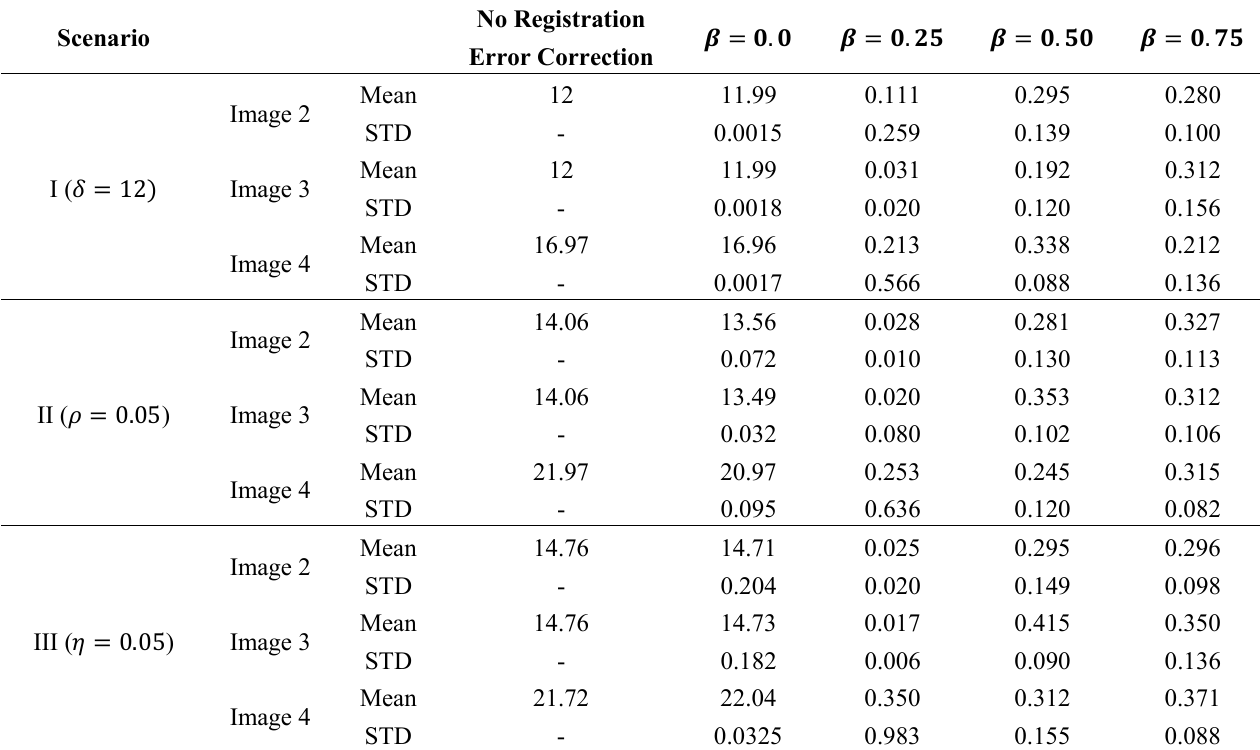
Table 5. The residual registration errors of our proposed algorithm for various scenarios and values of